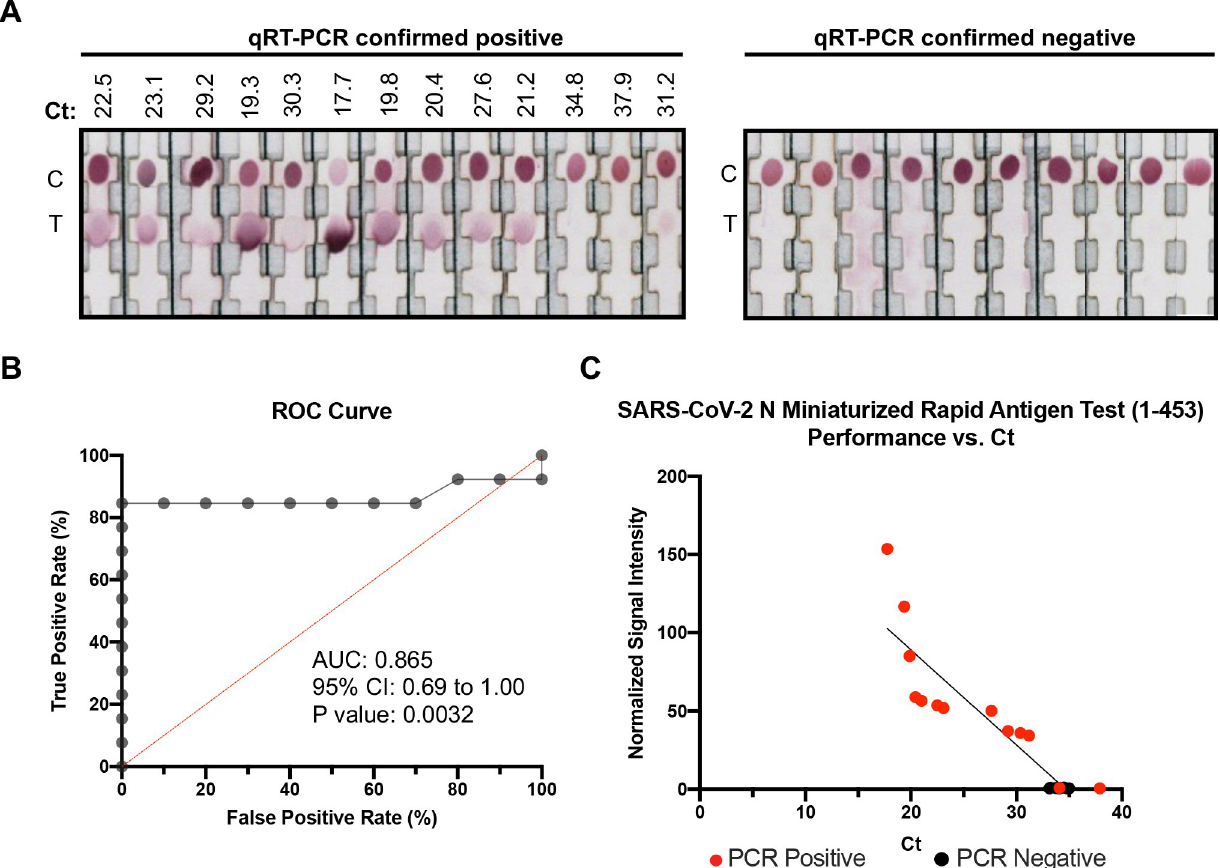
Fig 5. SARS-CoV-2 N rapid antigen test performance. (A) Nasal swab specimen (50 μ l) collected from qRT-PCR confirmed positive patients (n = 13) and negative patients (n = 10) were allowed to react with a SARS-CoV-2 N rapid antigen test composed of mAbs 1–453. Ct, Cycle threshold value. C, control. T, test. (B) Receiver operator characteristic (ROC) curve of SARS-CoV-2 N rapid antigen test. Test performance is demonstrated in terms of true positive rate (sensitivity) versus false positive rate (1-specificity). AUC, area under the curve. CI, confidence interval. (C) Normalized signal intensity was compared to the qRT-PCR-derived sample cycle threshold (Ct) value. Points are plotted with a linear regression line of y = -6.378x + 21 and p < 0.0001 and R 2 = 0.847.